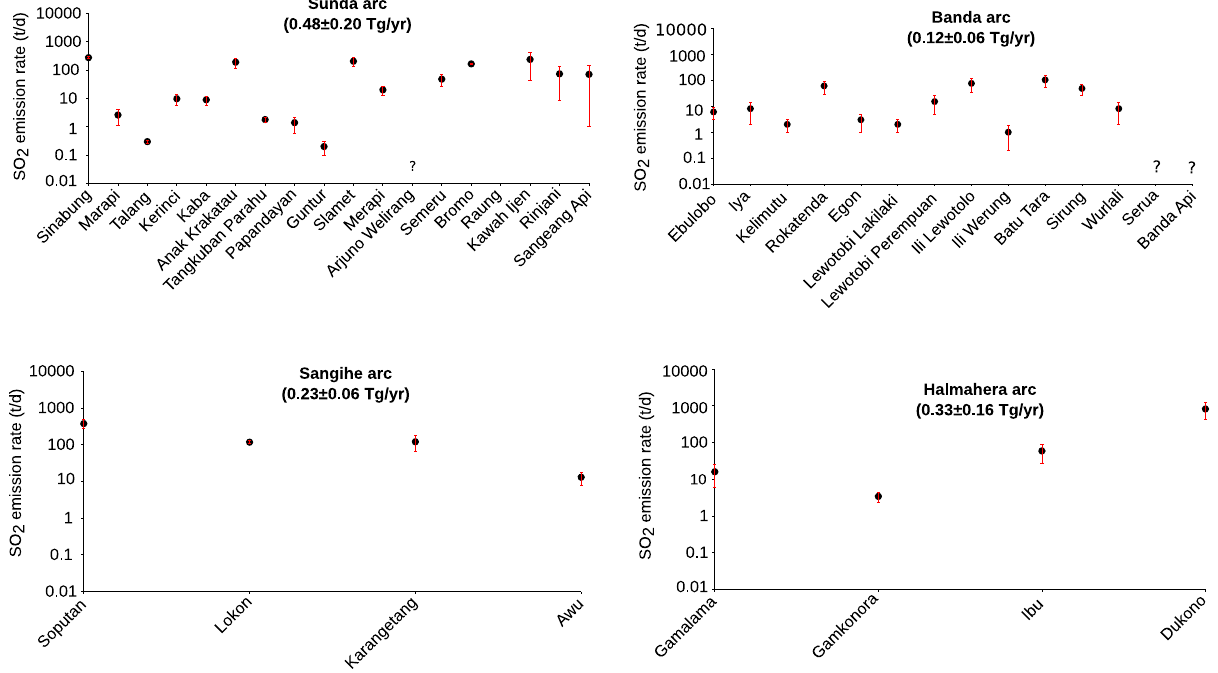
Table 4 Number of eruptive events per year and the corresponding SO 2 release per arc for 2010 – 2020 period for both from satellite and VEI results.